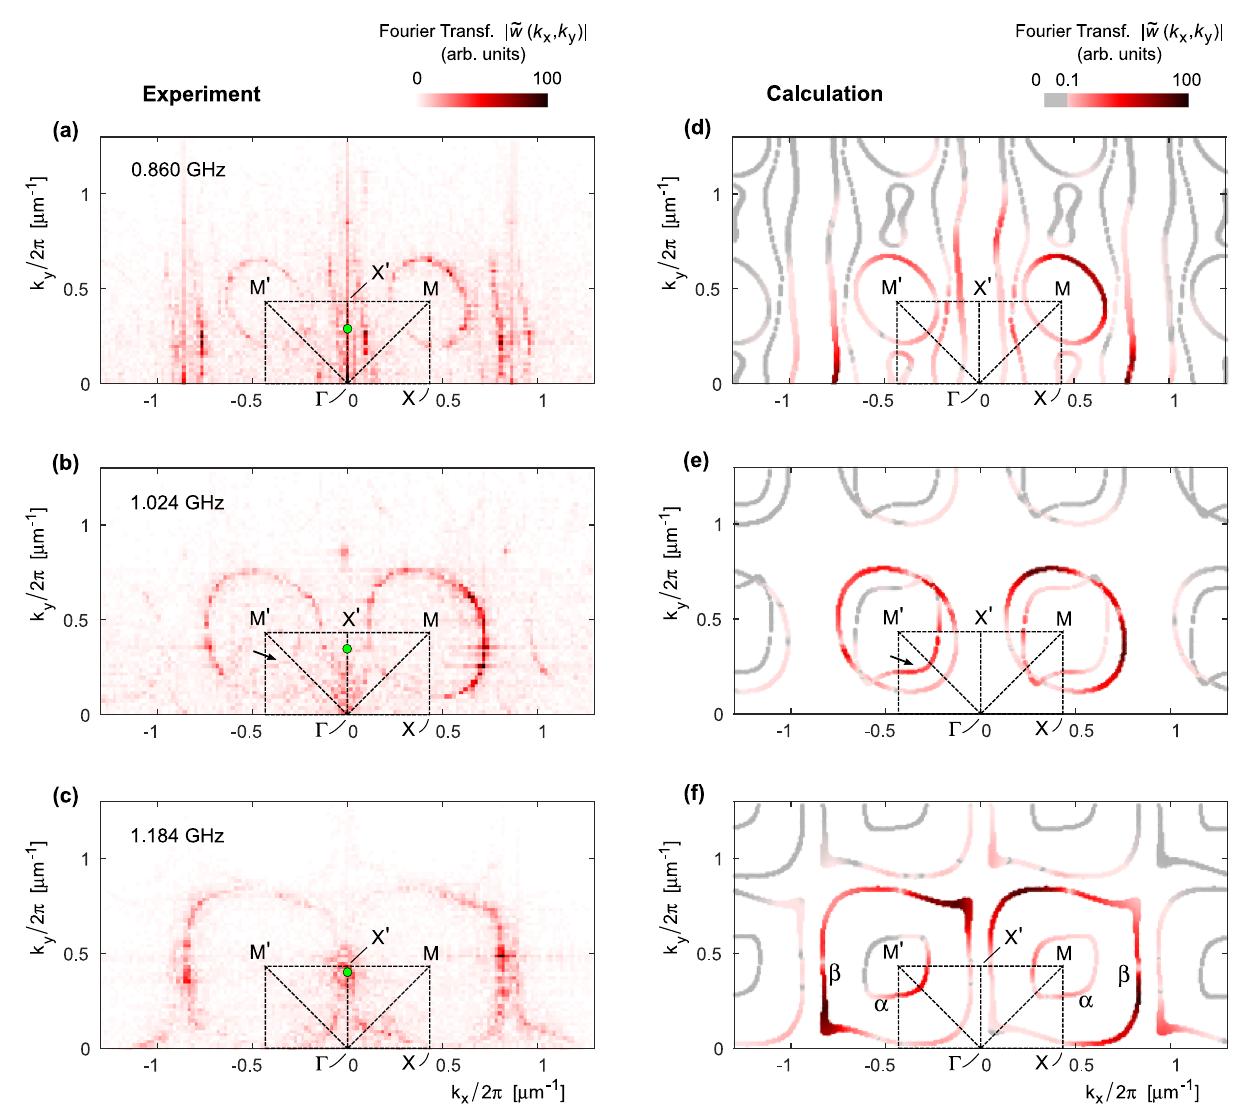
Fig. 3 | Isofrequency curves in the reciprocal space. Experimental ( a – c ) and simulated ( d – f ) reciprocal space maps for three different excitation frequencies, evidencing the Bloch mode isofrequency curves. The color encodes the modulus of the Fourier transform of out-of-plane mechanical displacement. The variations of such values (along a speci fi c isofrequency curve, and among different curves) originate from two mechanisms: (i) intrinsic values of out-of-plane displacement for the different eigenstates, (ii) unequal coupling ef fi ciency between the